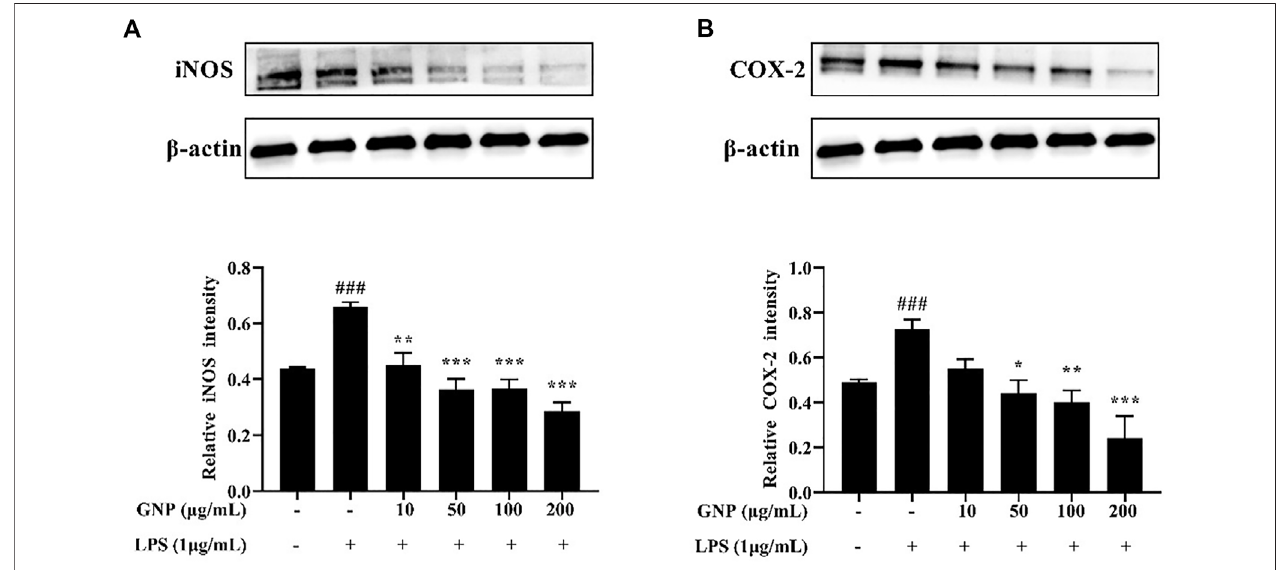
FIGURE6| EffectofGNPoniNOSandCOX-2proteinlevelsinLPS-inducedRAW264.7cells.CellsweretreatedwithGNP(10,50,100,and200 μ g/ml)for2hand then treated with LPS (1 μ g/ml) for 24 h (A) iNOS protein expression and (B) COX-2 protein expression. Data are expressed as mean ± SD (n (cid:1) 3). (# indicates the signi fi cant difference between the LPS group and the blank group, # p < 0.05, ## p < 0.01, ### p < 0.001; * indicates a signi fi cant difference between the experimental group and the LPS group, * p < 0.05, ** p < 0.01, *** p < 0.001).